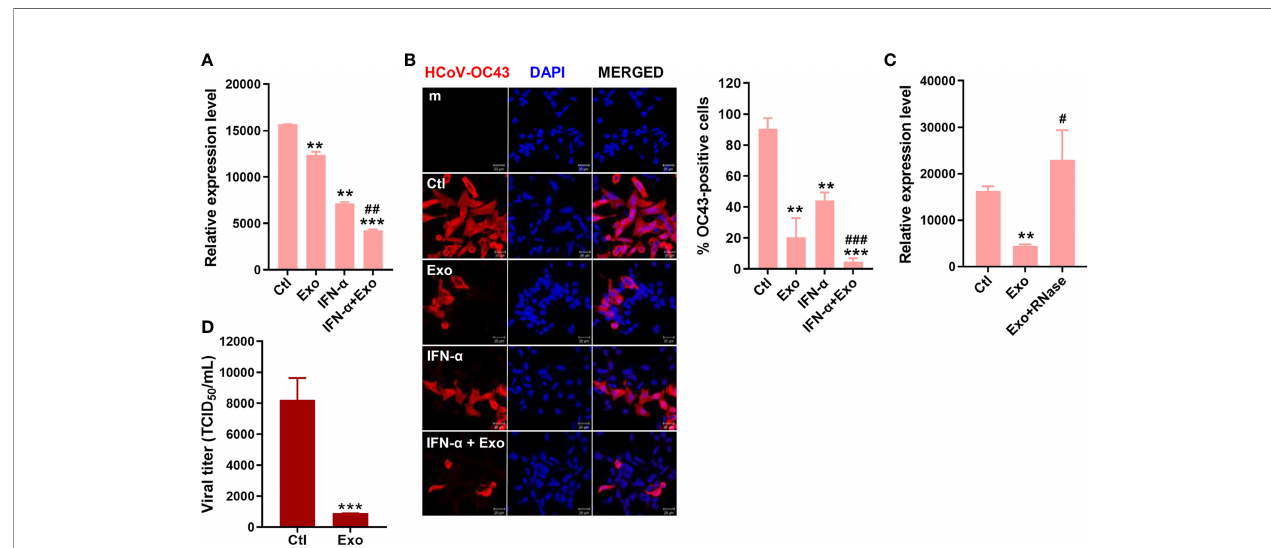
FIGURE 5 | U-exo treatment reduces HCoV replication and shows a synergistic effect with IFN-a on HCoV infection. (A) HCT8 cells were infected with HCoV-OC43 at an MOI of 1. After viral attachment, cells were treated with control (Ctl), U-exo (Exo), IFN- a (10 ng/mL), or IFN- a combined with U-exo (IFN- a +Exo) for 5 days, after which viral gene expression levels were measured using RT-qPCR. Transcriptional expression of the viral nucleoprotein ( NP ) was quanti fi ed and the expression levels of viral genes were normalized to GAPDH . (mean ± SD; n = 3). (B) Immuno fl uorescent staining of HCoV-OC43 at 5 days post infection was visualized by confocal microscopy. Scale bar represents 20 m m. % OC43-stained cells were calculated and the graph shows an average of three independent experiments. Statistical analysis: **p < 0.01; ***p < 0.001, versus Ctl-treated cells. ## p < 0.01; ### p < 0.001, versus IFN- a -treated cells. (C) U-exo were exposed to 1 m g/mL RNase for 1 h and added to cells. Viral NP expression was measured (mean ± SD; n = 3). Statistical analysis: **p < 0.01; versus Ctl-treated cells. # p < 0.05, versus U-exo (Exo)-treated cells. (D) MRC-5 cells were infected with alpha-coronavirus (HCoV-229E) (MOI 1) for 5 days. Supernatant was collected for TCID50 assay. Viral titers were measured using the TCID50 assay and expressed as TCID50/mL (means ± SD; n = 3). Statistical analysis: ***p < 0.001; compared with Ctl-treated